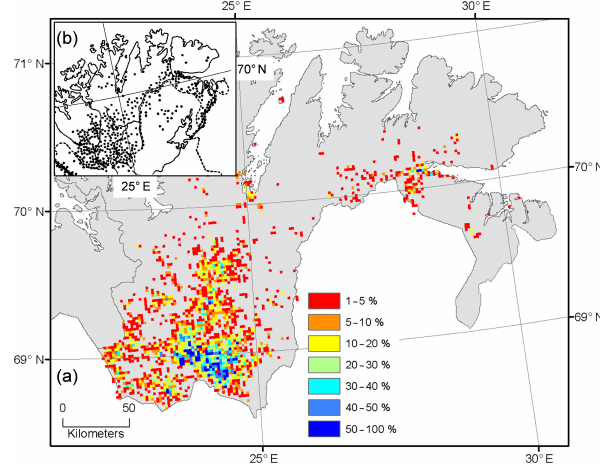
Figure 4. Distribution of palsas and peat plateaus in Finnmark at 2km resolution. The concentration reflects the proportion (in percent) of 250m grid cells that has presence of palsas in 2km grid cells. The inlet map (b) shows the distribution of palsa mires mapped by Sollid and Sørbel (1998) based on work from the 1960s– 1970s (Sollid and Sørbel,